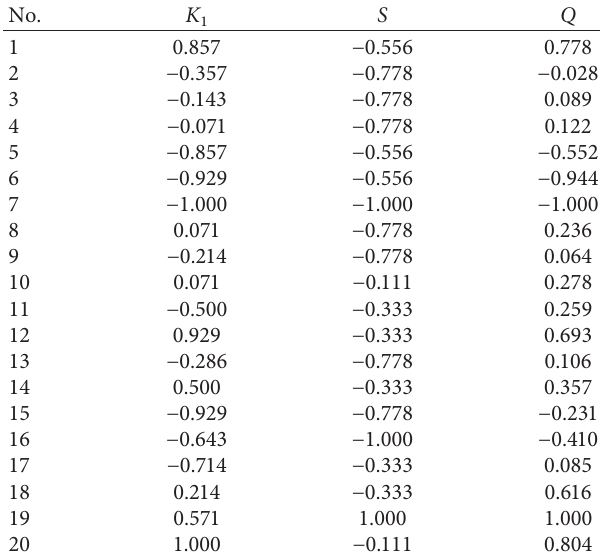
Table 2: Standardized collected